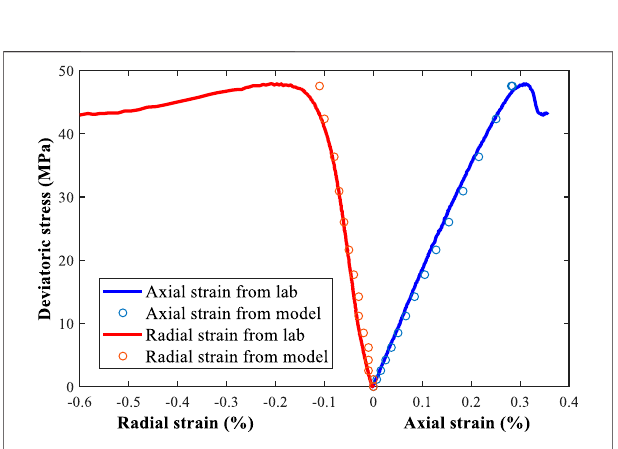
FIGURE 7 | Matching between lab and modeling results for linear elasticity. Note that only linear regimes are studied.